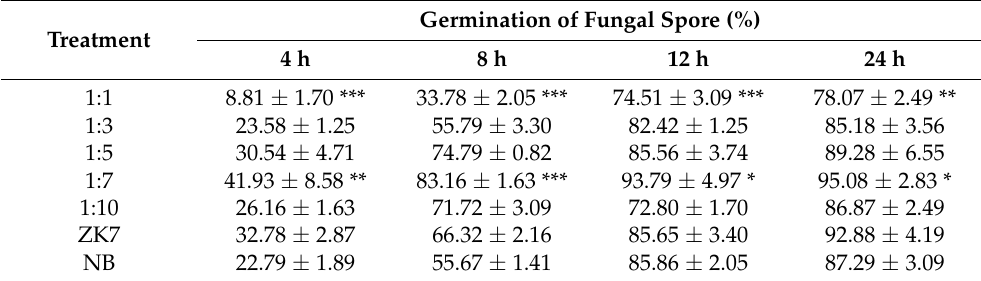
Table 3. Influences of B. nematocida B16 supernatant on germination of fungal spore. Germination of Fungal Spore (%) Treatment